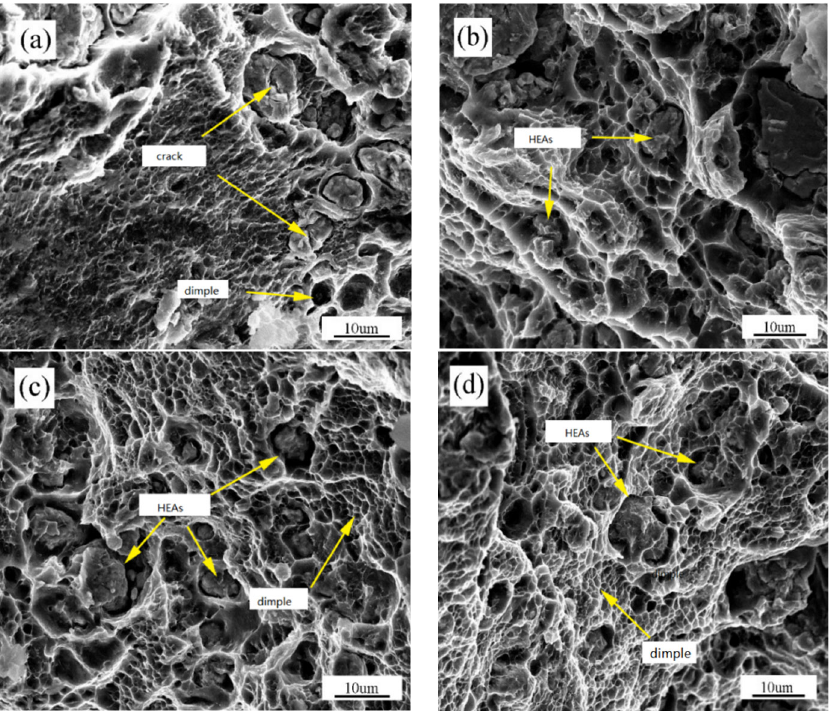
Figure 16. Tensile fracture morphologies of 10 vol.% HEA composites under different extrusion passes: ( a ) one pass; ( b ) two passes; ( c ) three passes; and ( d ) four passes.